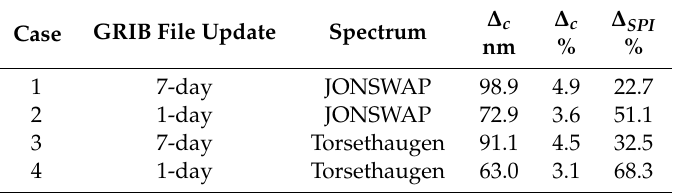
Figure 5. Minimum distance (great circle) and optimal route detection, F N = 0.15 (reversed travel direction): ( a ) Case 1; ( b ) Case 2; ( c ) Case 3; ( d ) Case 4. Table 4. Results of optimal route detection, F N = 0.15 (reversed travel direction).